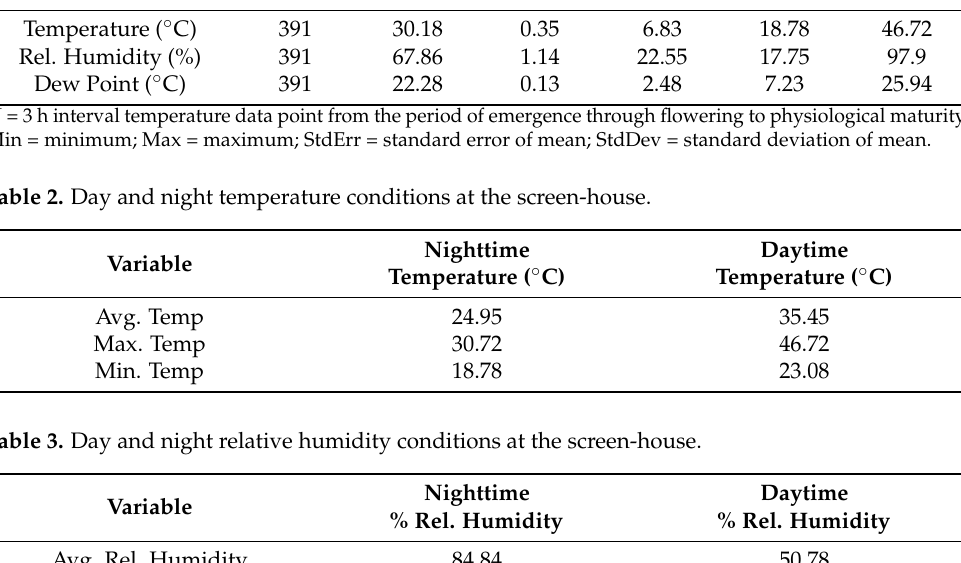
Table 1. Statistics of temperature and humidity conditions at the screen-house. Parameter N Mean StdErr StdDev Min Temperature ( ◦ C)